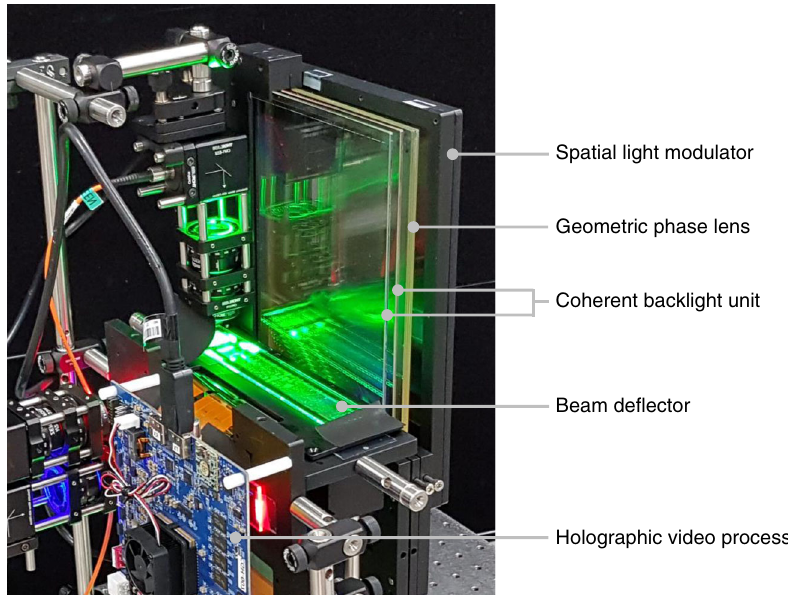
Fig. 4 Slim-panel holographic video display. The prototype includes optical components (beam de fl ectors, coherent-backlight units, and a geometric phase lens), a holographic video processor board, a spatial light modulator, power connectors, and other miscellaneous components. The thickness of the display parts is 1 cm, including coherent-backlight units, a geometric phase lens, and a spatial light